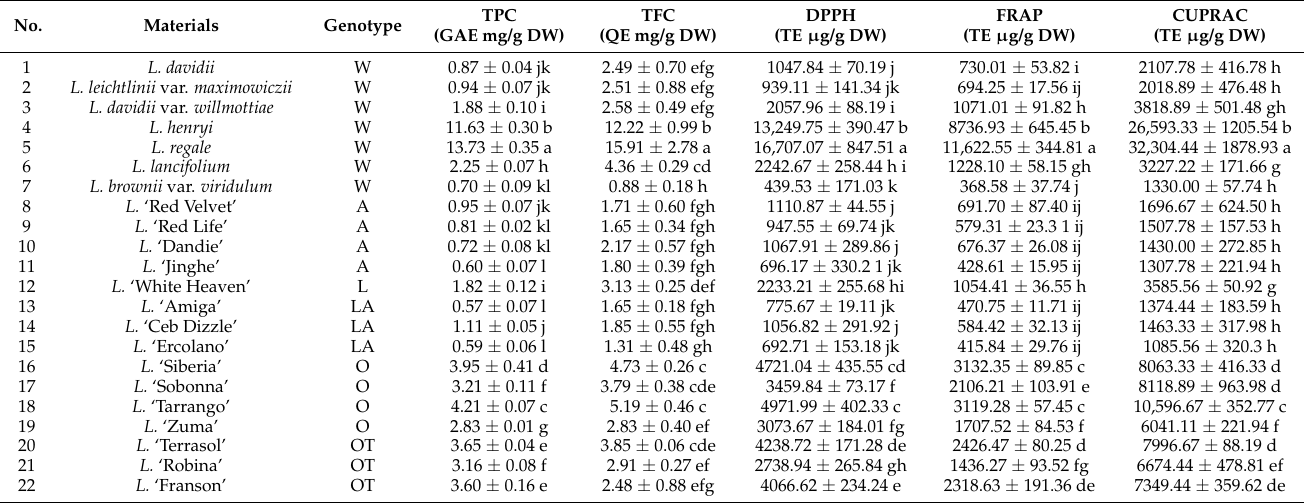
Table 2. TPC, TFC and antioxidant activities of different lily